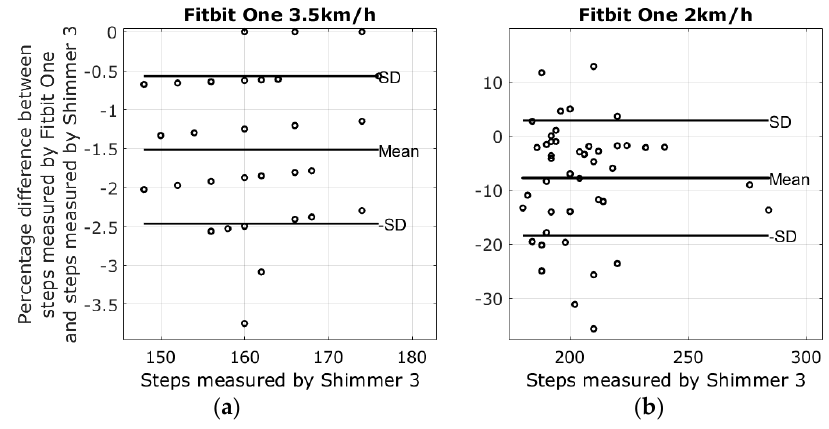
Figure 5. Results from the walking tests with plots showing the difference between the steps measured by the Fitbit One and the Shimmer 3. ( a ) The percentage error of the 3.5 km/h walking test is − 1.5 ± 0.9; ( b ) The percentage error of the 2 km/h walking test − 7.8 ± 10.5.